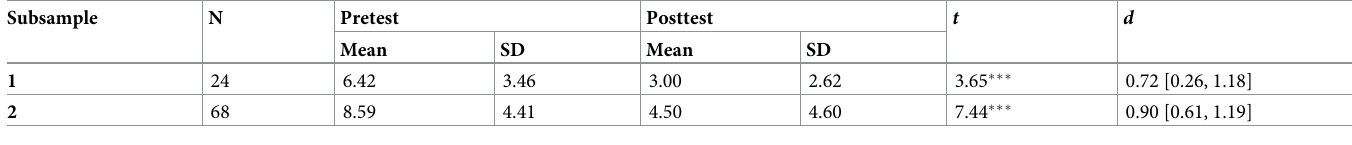
Table 7. Descriptive and inferential results from the two subsamples for the OASIS scores on the pretest and the posttest.